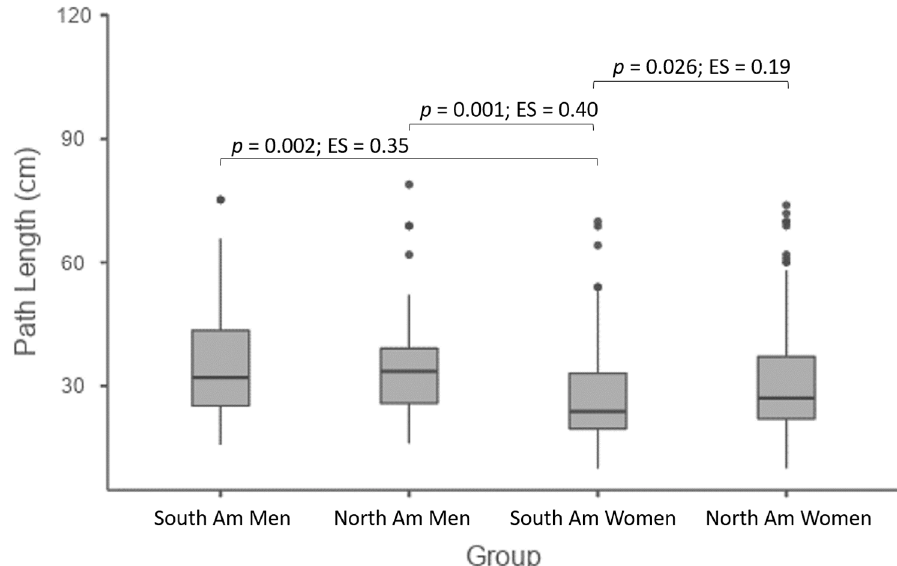
Figure 2. Box plot of pairwise comparisons. Box trace = median values; box limits = minimum–maximum; vertical trace = standard deviation; dots = outliers; ES = effect size. Significant differences assigned.